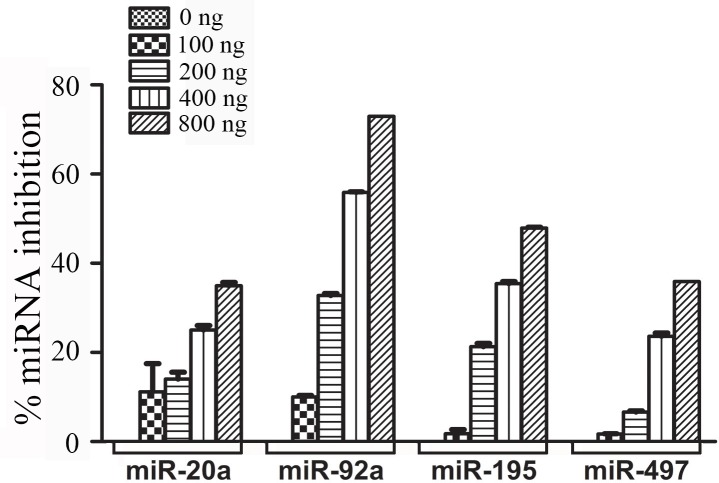
Dose-dependency of dTuD on the expression of related miRNAs.293A cells were transfected with dTuD targeting miR-20a, -92a, -195 or -497 at the concentration of 0, 100, 200, 400 and 800 ng/mL. qRT-PCR was performed to evaluate the expression of miRNA. Data was shown as the percentage of miRNA in the cells transfected with dTuD via that in the cells transfected with dTuD-Ctrl. Data were represented as the mean ± SD (n = 3).